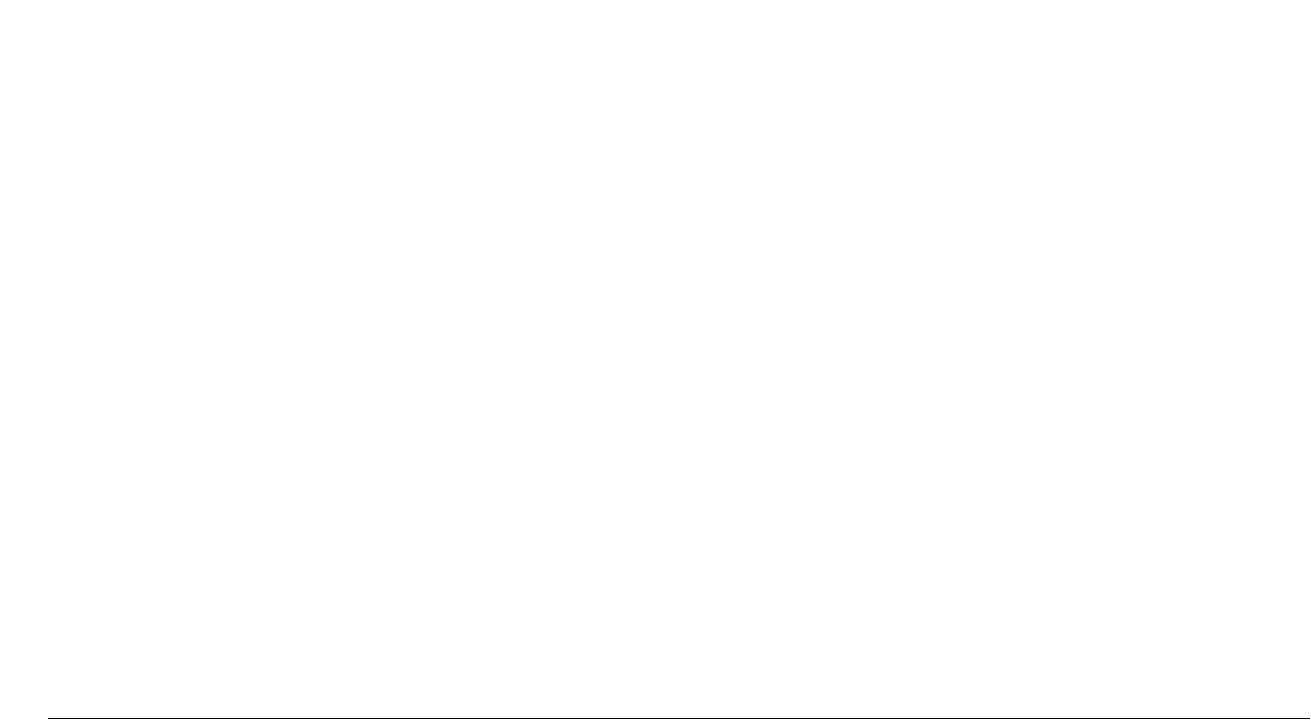
FIGUREA3 |The relationship between the presence/absence of genes involved in DNA repair and bacterial genome GC content. Plots show presence or absence of (A) mutM (B) mutY (C) mutL (D) mutS . Data was generated from 699 complete eubacterial genomes. Intracellular and extracellular bacteria are